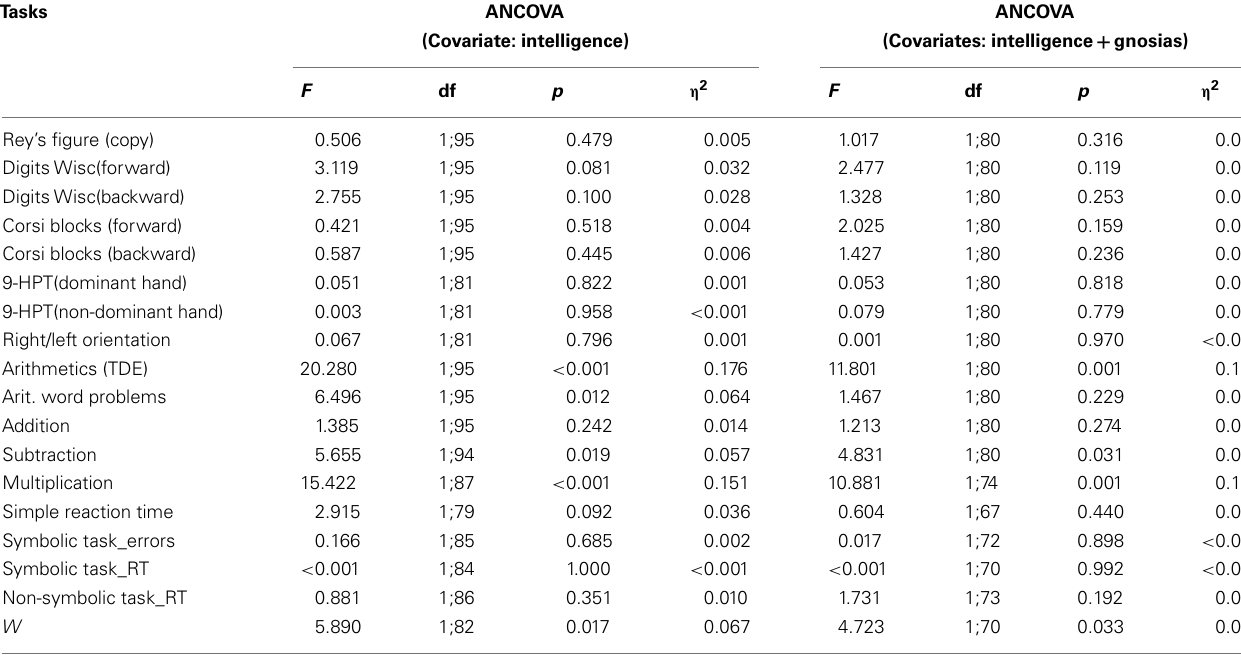
Table 3 |Analysis of covariance of the neuropsychological tasks (ANCOVA). Tasks